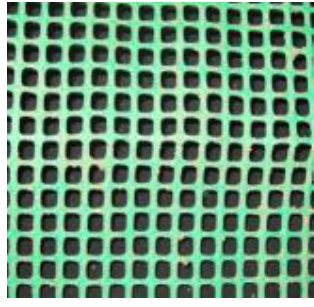
Figure 2. Geogrid. Figure 2. Geogrid.